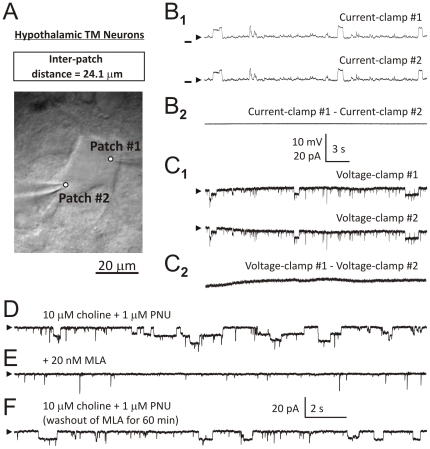
Somatic integration of individual α7 channel activity in hypothalamic TM neurons.A large hypothalamic TM neuron with two attached patch-clamp electrodes and an inter-patch distance of 24.1 µm (A). Examples of patch-clamp recordings obtained from the neuron shown in (A) when both patch electrodes are in current-clamp (B) or voltage-clamp at −70 mV (C). The bottom traces in B–C) are results of subtraction of trace #2 from trace #1 indicating identical patterns of TM α7 single ion channel activity recorded by the two electrodes (see text). Horizontal bars in (B) indicate the membrane voltage of −75 mV. A continuous hyperpolarizing current (50–120 pA) was injected into cells to cease spontaneous firing. The baselines are indicated by arrowheads. Step-like responses (D) were completely (E) and reversibly (F) blocked by 20 nM MLA, a selective α7 nAChR antagonist, added to ACSF.